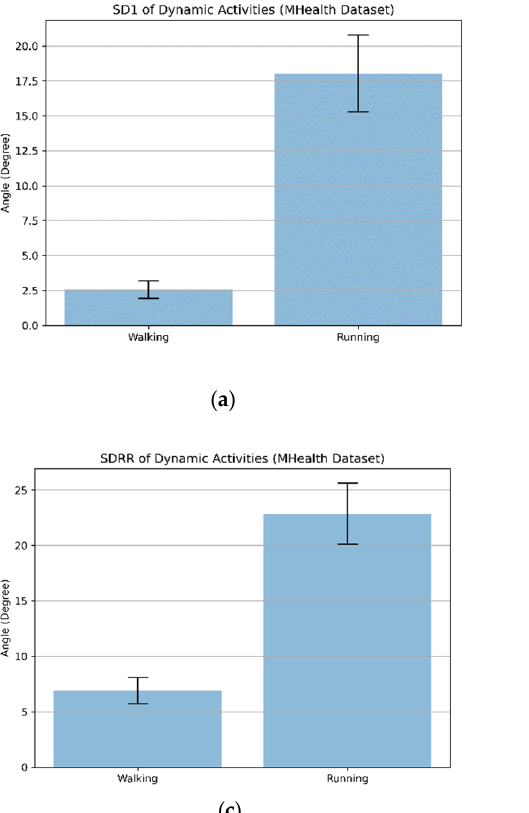
Figure 8. ( a – c ) Bar plot of SD1, SD2, and SDRR, respectively, of dynamic activities (walking and running) with the MHealth dataset.